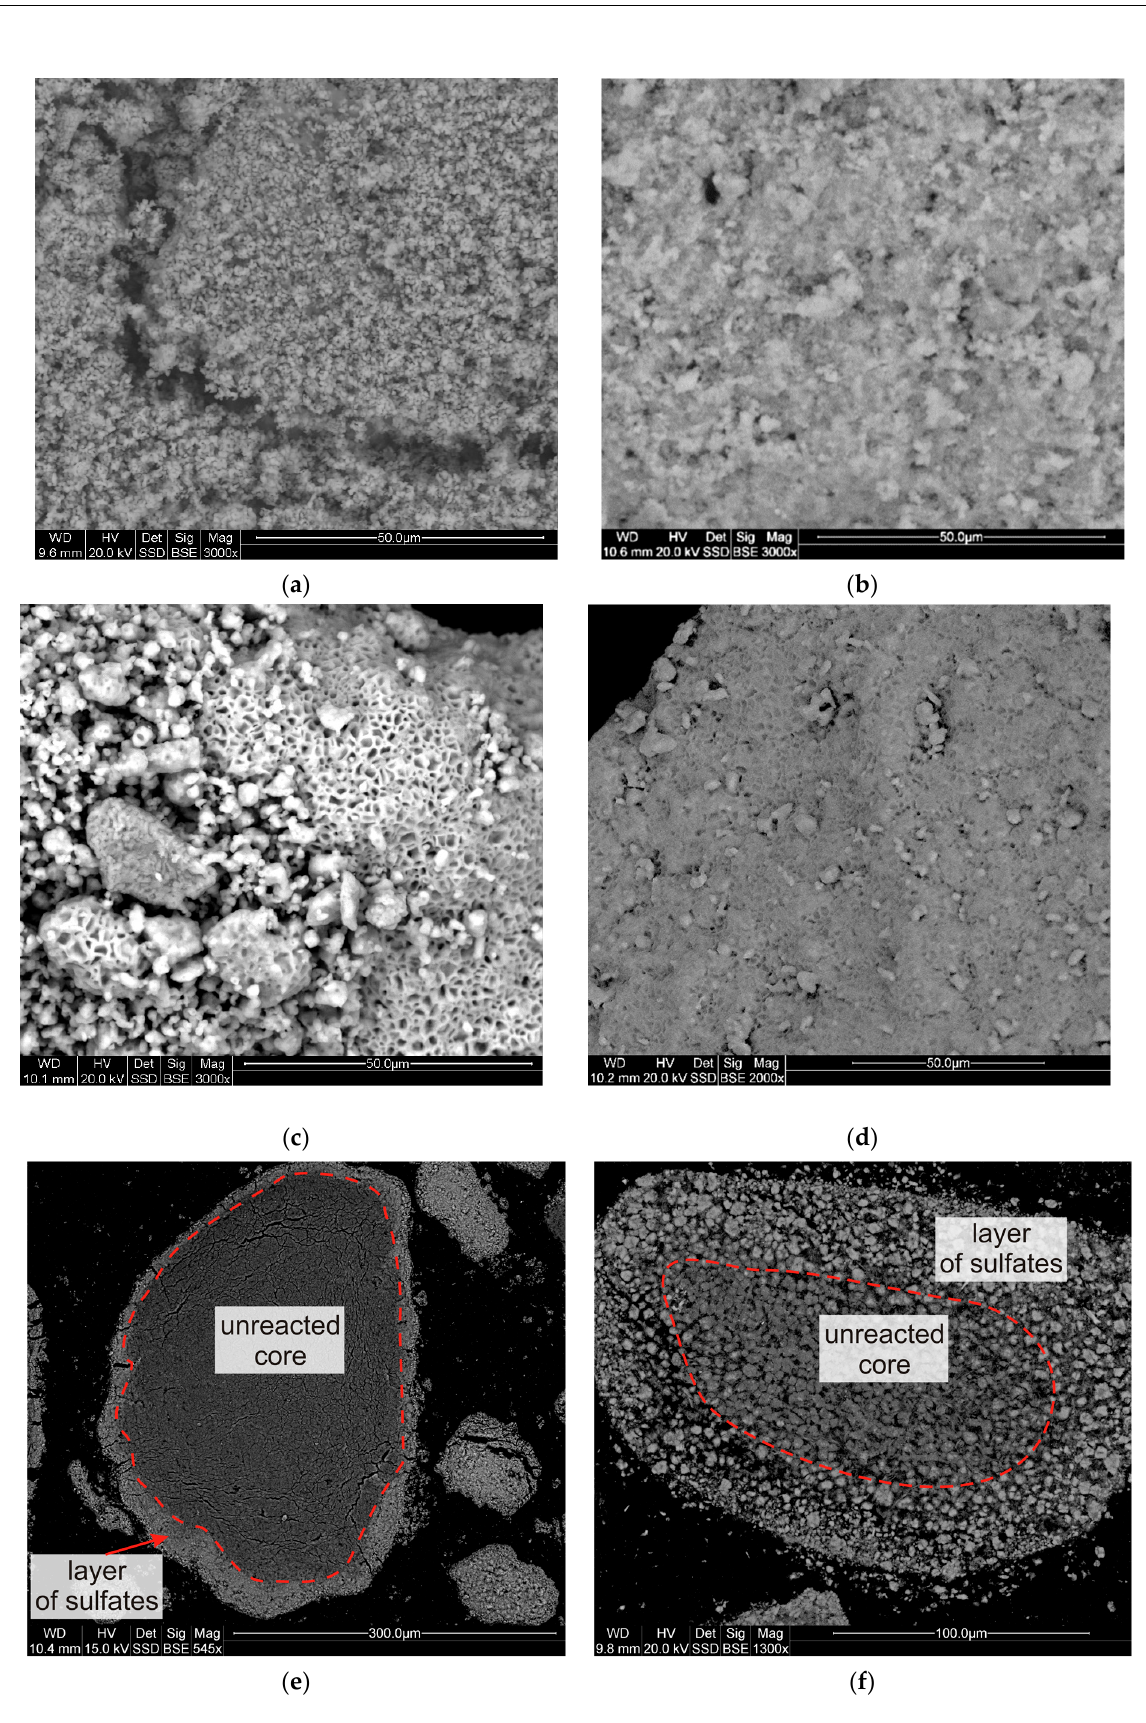
Figure 10. Magnesites from Wiry ( a – c ) and Szklary ( d – f ): ( a , b ) samples after the decarbonation process; ( c – f ) after the sulfation process; ( c , d ) grain surface; ( e , f ) cross-section through the grain.